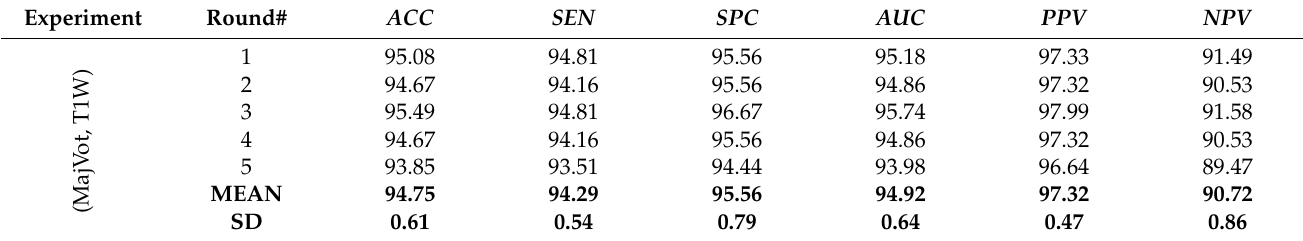
Table A8. Test results of five-folds of experiment (MajVot, T1W).